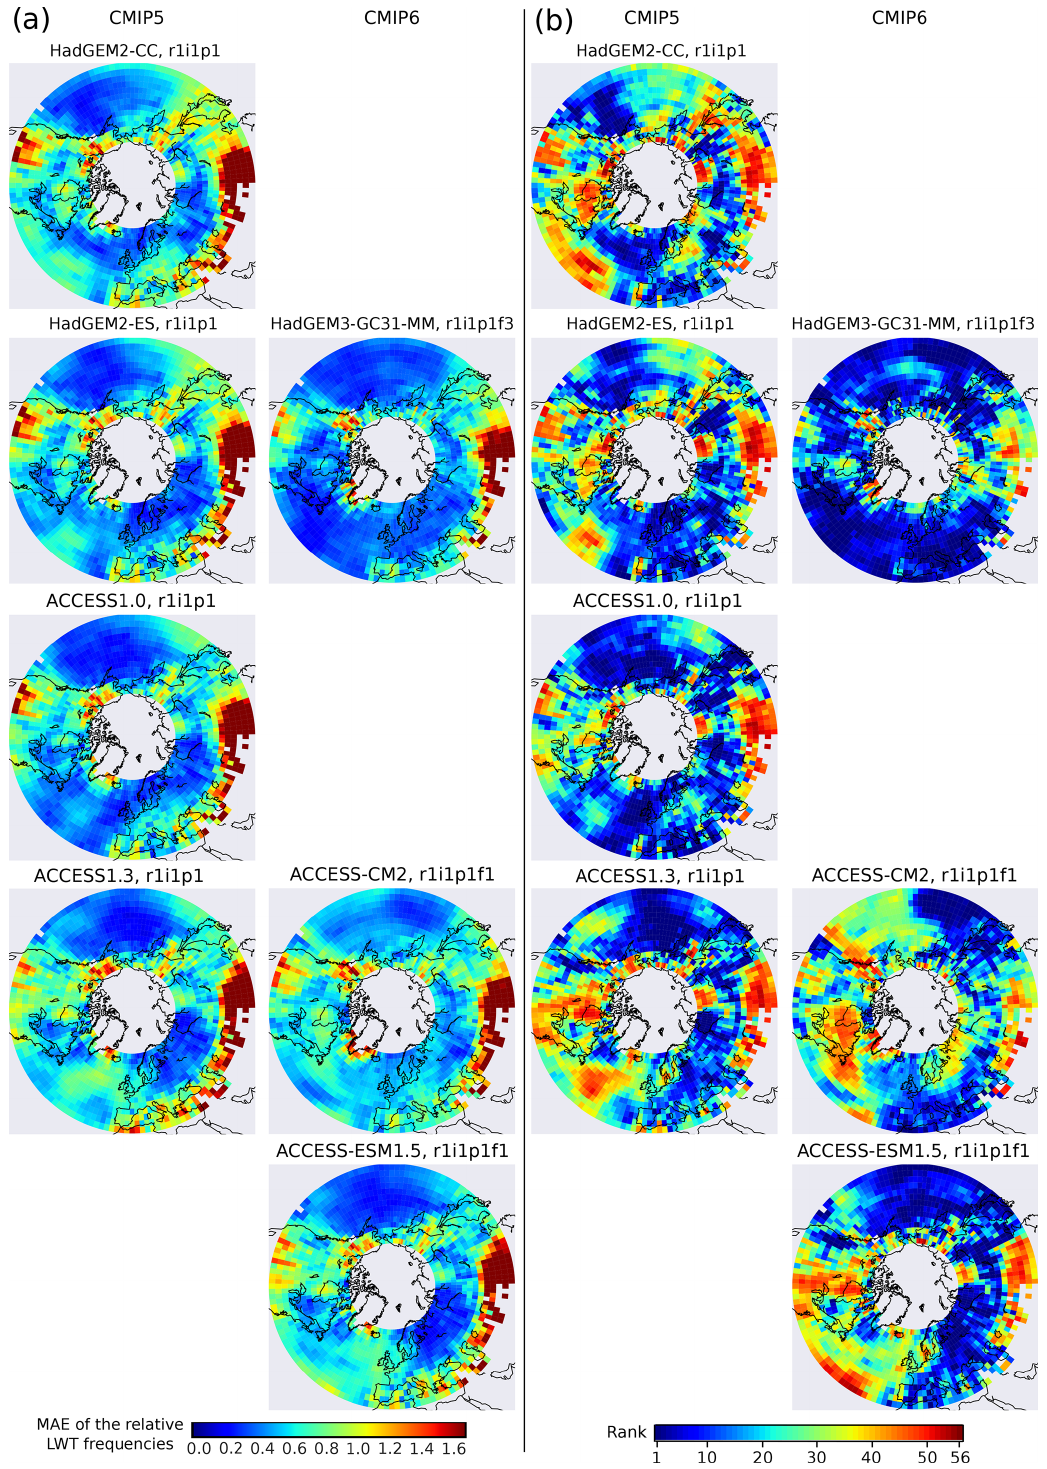
Figure 3. Mean absolute error of the relative Lamb weather type frequencies from the historical CMIP experiments with respect to ERA- Interim (column a ), as well as the respective rank within the 56 distinct model versions outlined in Table 1 (column b ). The lower the rank, the lower the MAE and the better the model. Results are for the Met Office Hadley Centre and ACCESS model families. Model pairs from CMIP5 and 6 are plotted next to each other. Results are for the 1979–2005